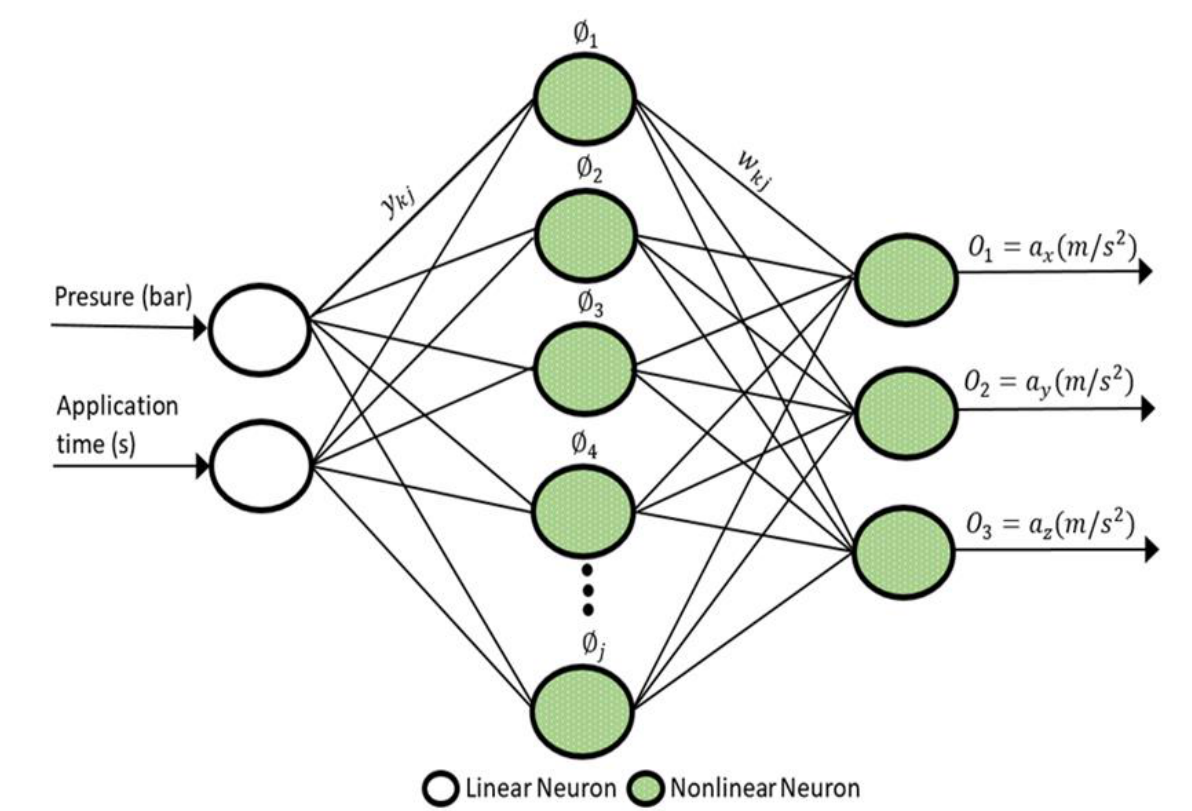
network structure consists of an input layer, hidden layer, and output layer, as in the ANN. The schematic structure of the proposed RBANN is shown in Figure 5.